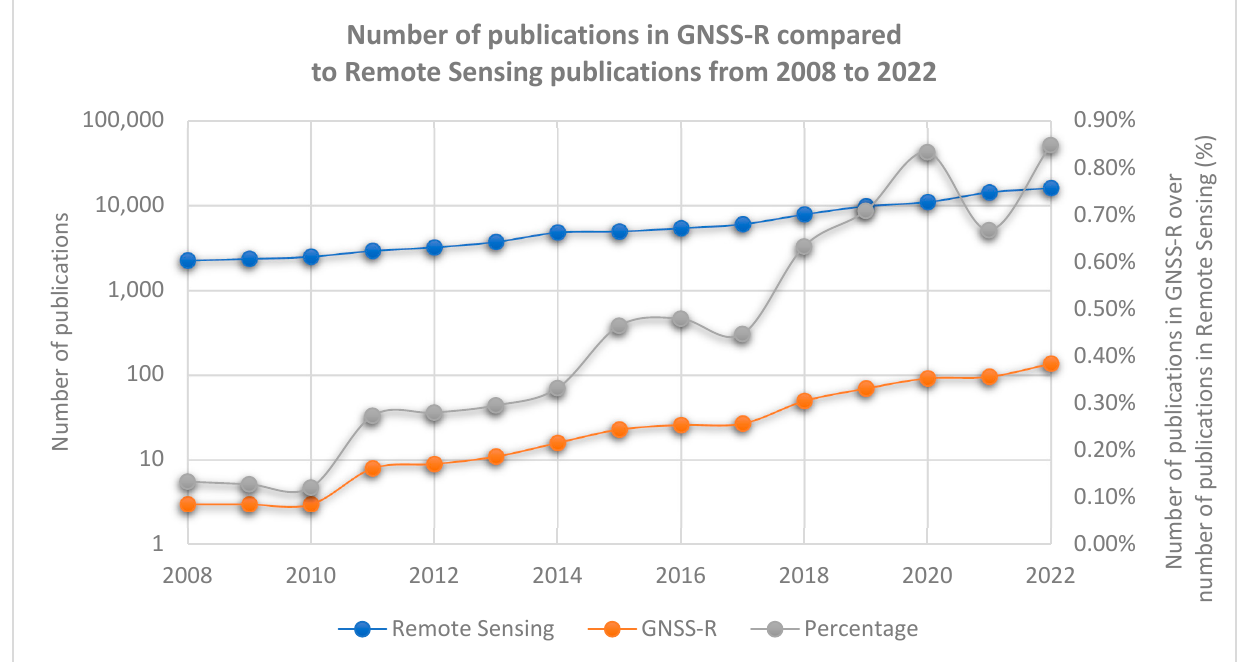
Figure 1. Progression of GNSS-R publications per year from 2008 to 2022. Left y axis describes the number of publications in the general remote sensing field (blue) and the number of publications specific to the GNSS-R field (orange). Right y axis describes the number of publications in GNSS-R over the number of publications in remote sensing, showing the growth rate. On 2022, the total number of remote sensing publications was 16,155, from which GNSS-R contributed 137 publications, representing 0.85% of the total. Data from the Clarivate Web of Science Core Collection. Remote sensing papers correspond to the search “remote sensing” in any field, and to “gnss-r” from the combination of “remote sensing and (re fl ectometry GNSS or GNSS-R or GNSS-IR). Data re- trieved in January 2023”.